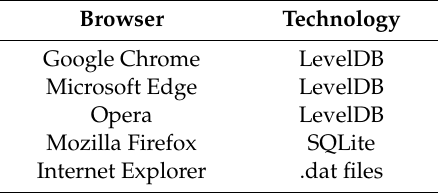
Table 2. IndexedDB Technology Across Di ff erent